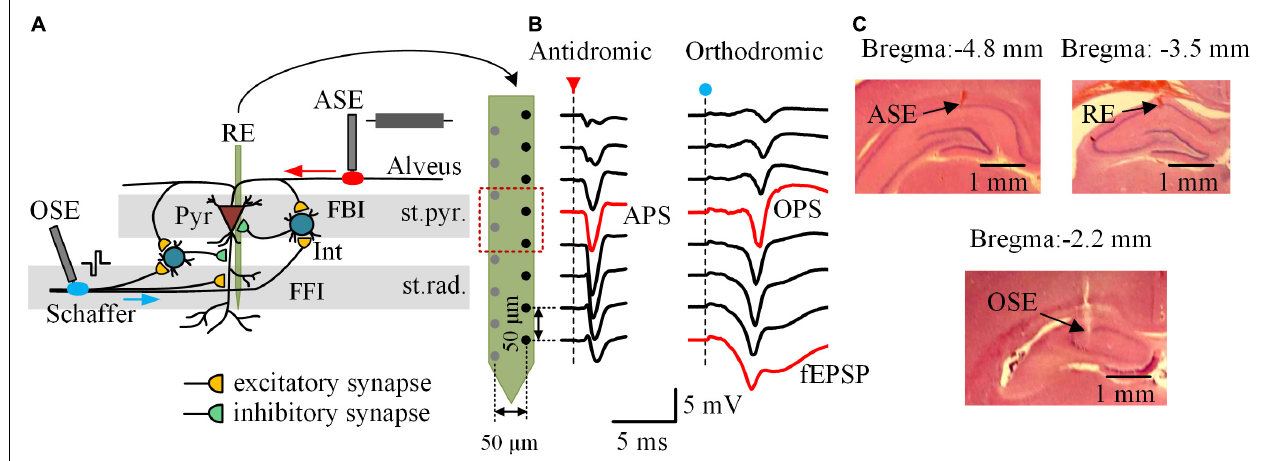
FIGURE 1 | Local neuronal circuits, neuronal potentials, and electrode placements in the rat hippocampal CA1 region. (A) Schematic diagram of the local neuronal circuits and the electrode placements. The 16-channel recording electrode (RE) was placed across the stratum pyramidale (st.pyr.) and the stratum radiatum (st.rad.) of CA1 region. The antidromic-stimulation electrode (ASE) and the orthodromic-stimulation electrode (OSE) were located at the alveus fibers and the Schaffer collaterals, respectively. Interneurons (Int) constitute local circuits of feedforward inhibition (FFI) and feedback inhibition (FBI) acting on the pyramidal cells (Pyr), the principal neurons in CA1 region. (B) Waveforms of evoked potentials along the half channels of RE following an antidromic-pulse (red arrow) and an orthodromic-pulse (blue dot), respectively. The antidromic population spike (APS) and orthodromic population spike (OPS) recorded in the st.pyr. as well as the field excitatory postsynaptic potential (fEPSP) recorded in the st.rad. were denoted in red. (C) Example photographs of histological brain slices showing the electrode tracks of ASE, RE, and OSE in the coronal sections of ∼ 4.8, ∼ 3.5, and ∼ 2.2 mm posterior to bregma,